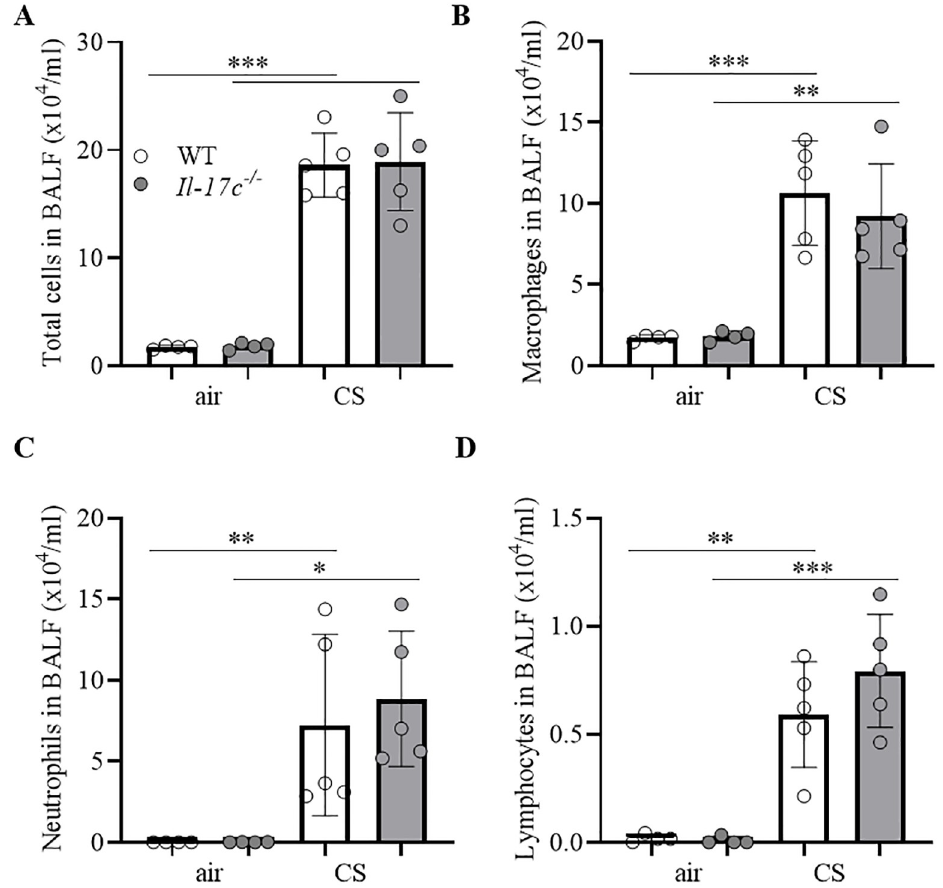
Fig 4. IL-17C does not contribute to CS-induced lung inflammation. WT and Il-17c -/- mice were exposed to CS for 4 weeks five times a week (days 1–5). Numbers of total immune cells (A), macrophages (B), neutrophils (C), and lymphocytes (D) were determined in BAL 24 hours after the final exposure to CS (n = 4–5 mice per group). Data were compared by unpaired Student’s t-test and are shown as the mean ± SD. � p < 0.05, �� p < 0.01, and ��� p < 0.001.